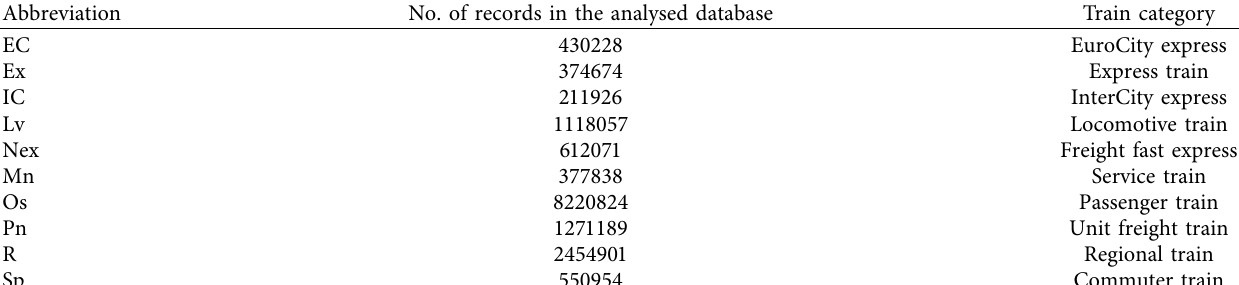
Table 1: Explanation of the analysed train category abbreviations and the processed amount of data.